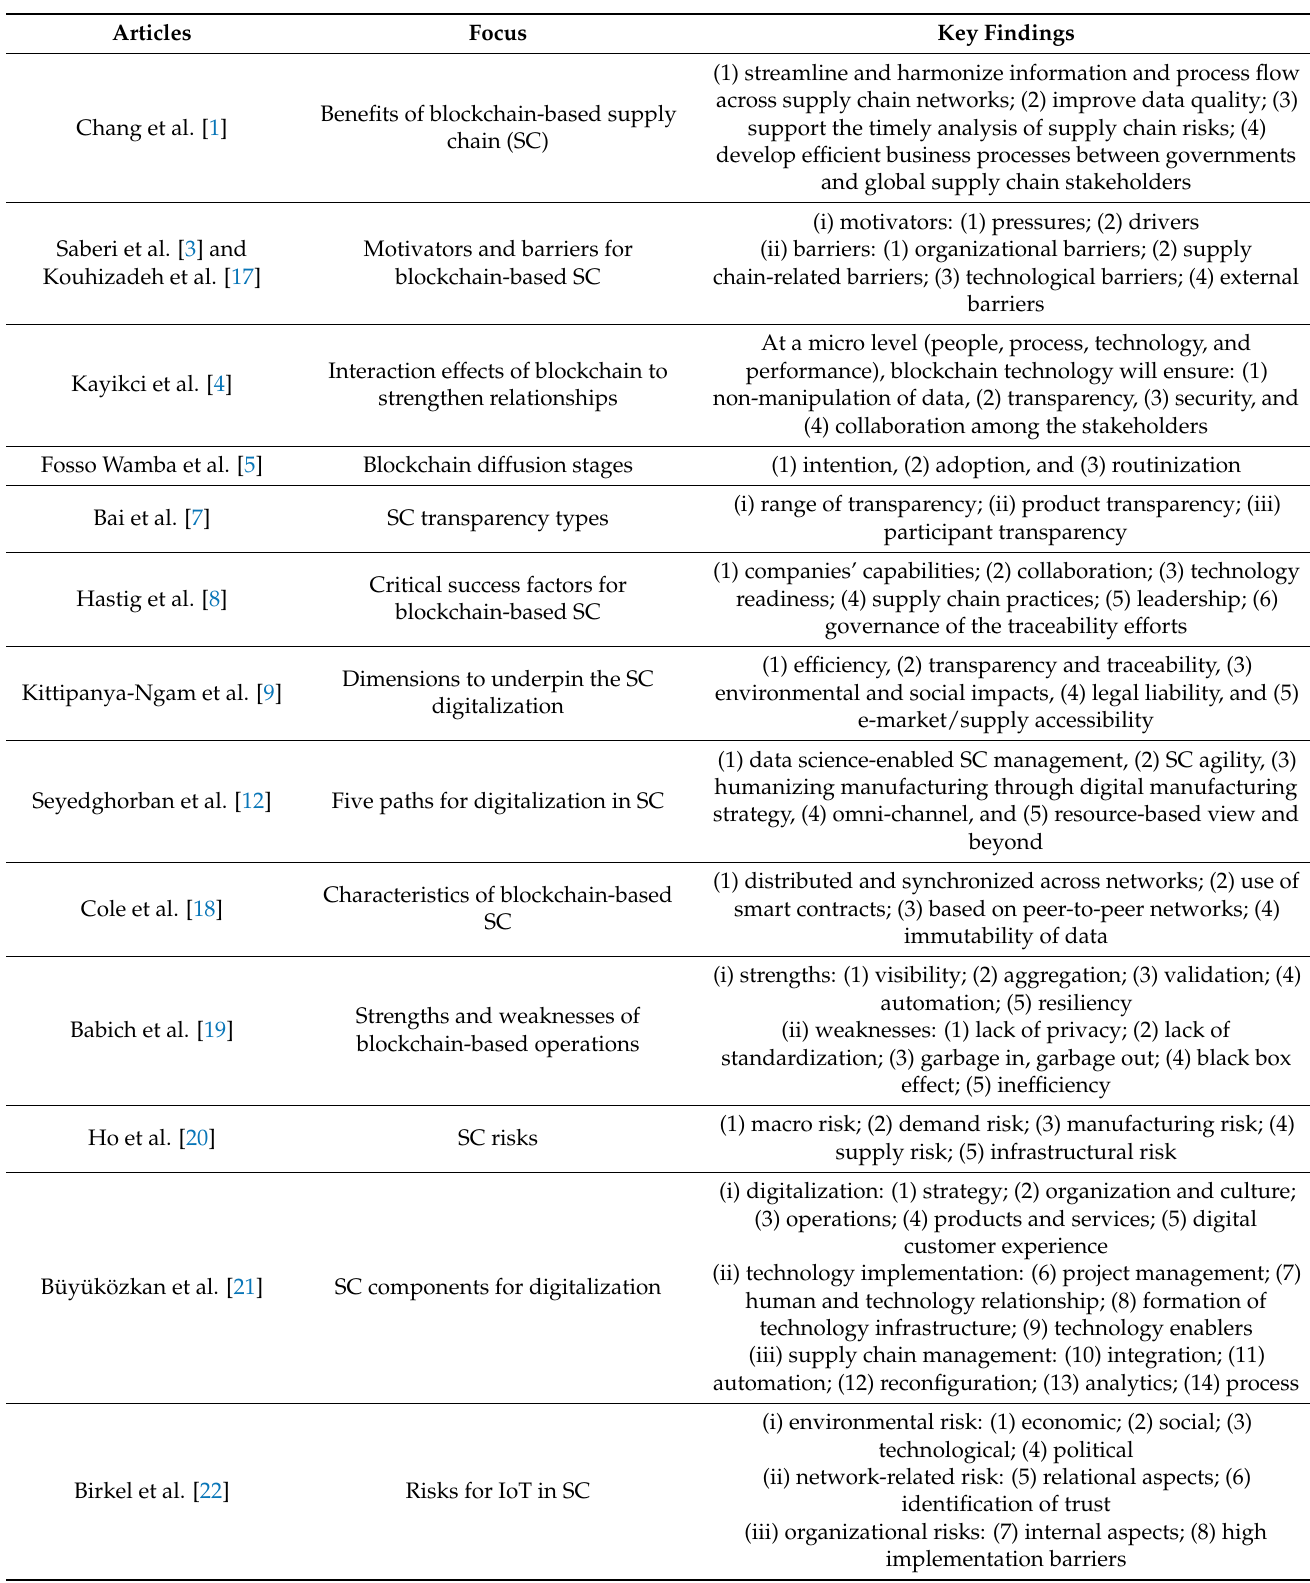
Table 1. Literature